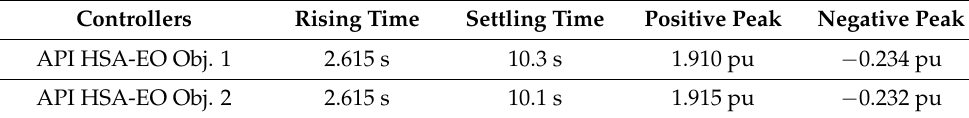
Table 17. Numerical comparison between the controllers at faulty fourth case.